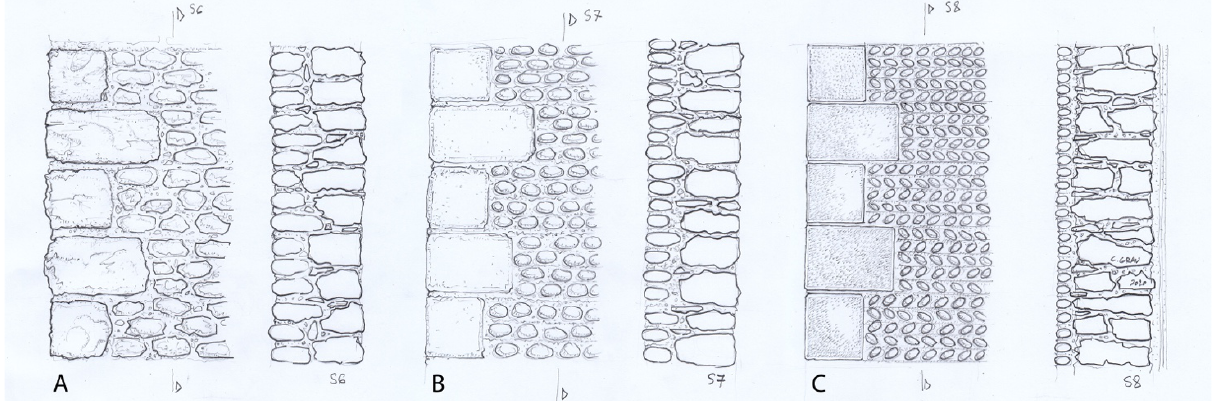
Figure 14. Drawing by the author of the main phases of cobblestone construction: A) early period, B) middle period and C) late period (Source: Moynihan, 2007. Drawings: C.J. Grau,